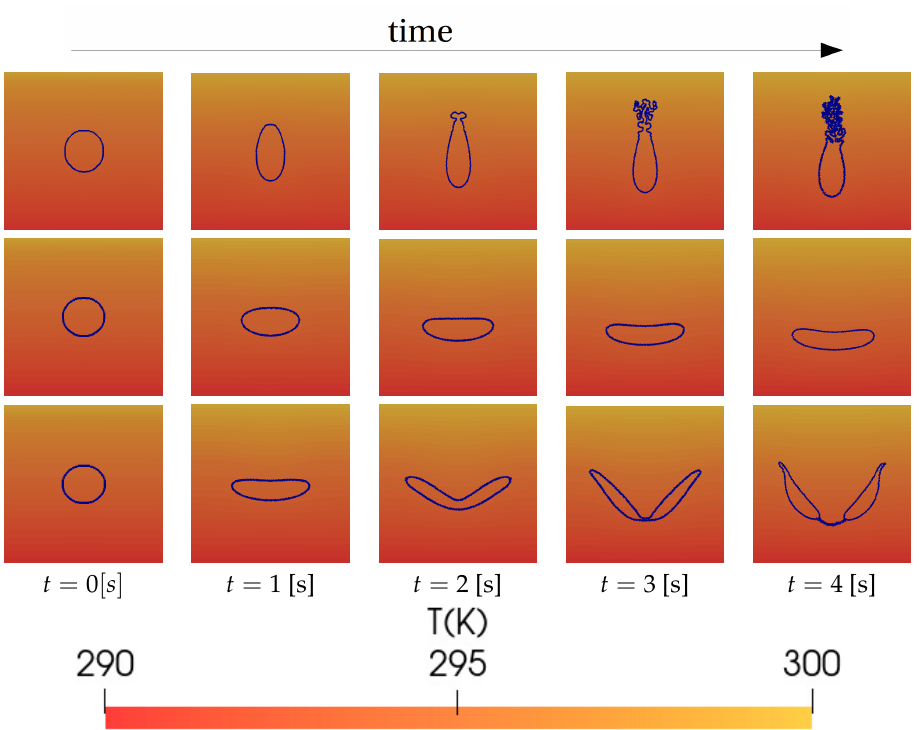
Figure 9. Time evolution of the droplet interface for EHD-TC coupled simulations; case 1 ( top row ), case 2 ( middle row ), case 3 ( bottom row ) with vertical temperature gradient set to 10 [K]. The physical simulation time t = 0 [s] at the very first frame on the left, up to t = 4 [s], with a time increment of 1 per frame. For the simulation parameters see Table